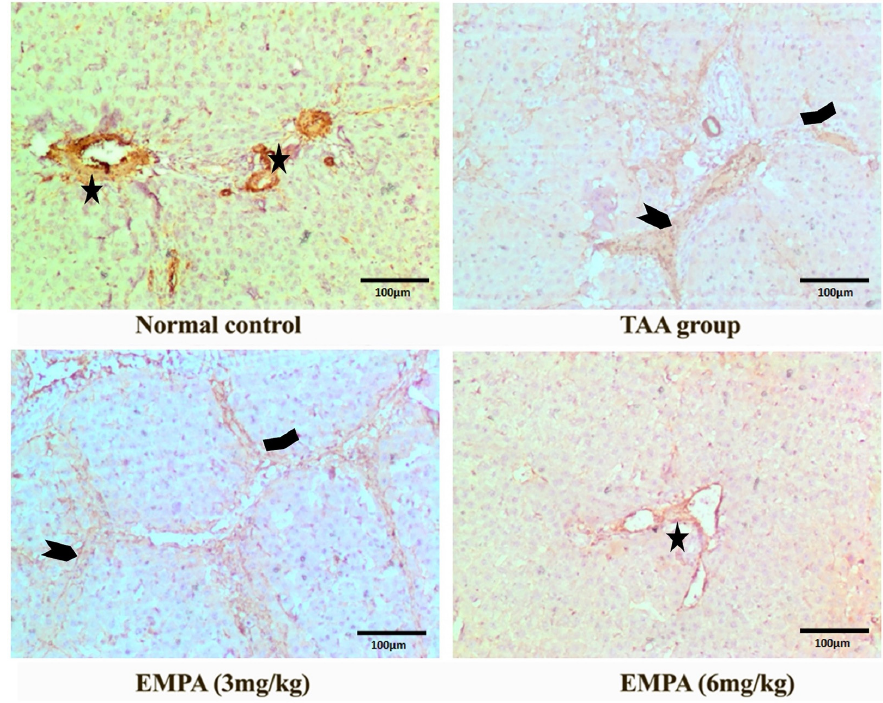
Figure 6. Photomicrographs of histopathology sections stained with immunohistochemical actin antibody. Only positive fibers in the wall of vascular structures (Asterisk) with no abnormal fibers deposition in the control group, positive thick fibers in a periportal fashion with porto-central (wide arrow head) and porto-portal extension (arrow heads) in the toxic group, persisting positive thick fibers and nodular cirrhotic pattern (arrow heads) with 3 mg group, regression of stain with almost negative expression in 6 mg group (magnification = 200×).